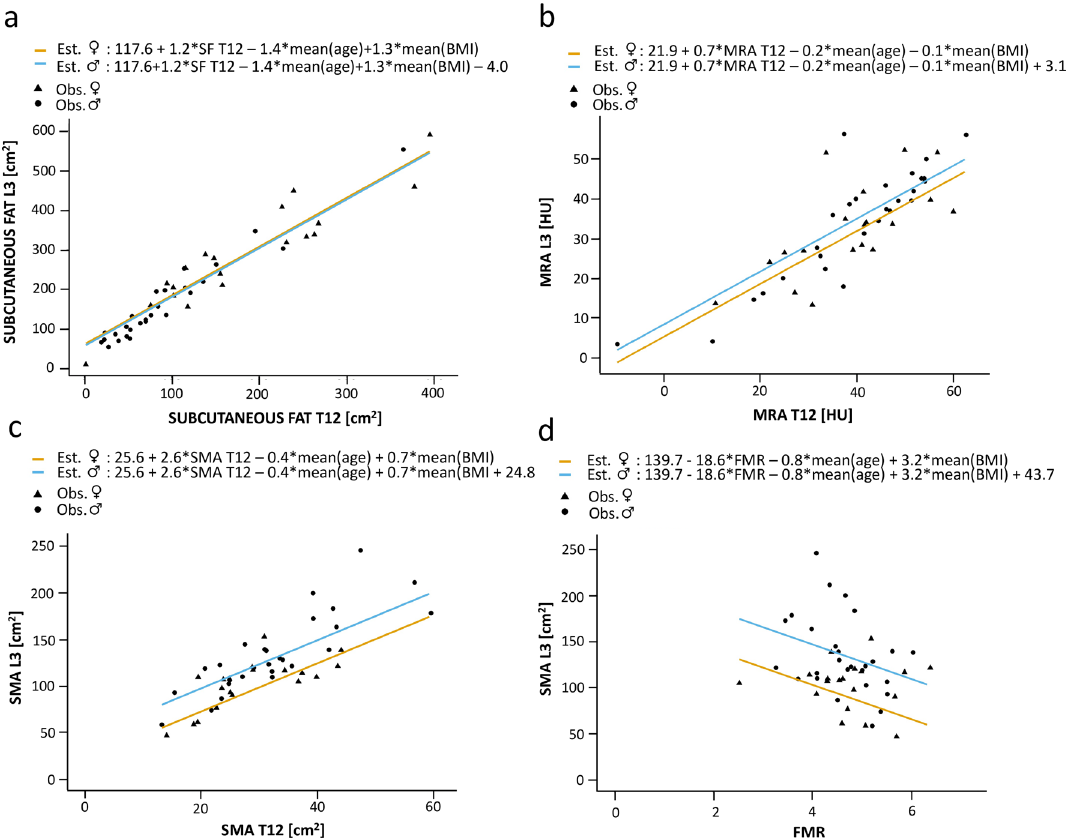
Figure 3. Sex-specific estimated regression lines. Results of multivariable linear regression analyses with the adjusting variables sex, age, and body mass index (BMI). The respective independent variables were subcutaneous fat (SF) at the twelfth thoracic vertebra (T12) ( a ), the muscle radiodensity attenuation (MRA) at T12 ( b ), the skeletal muscle area (SMA) at T12 ( c ), and the fat to muscle ratio (FMR) at T12 ( d ). Respective dependent variables were subcutaneous fat at the level of the third lumbar vertebra (L3) ( a ), the muscle radiodensity attenuation (MRA) at L3 ( b ), and the skeletal muscle area (SMA) at L3 ( c , d ). Est. = estimated, Obs. =